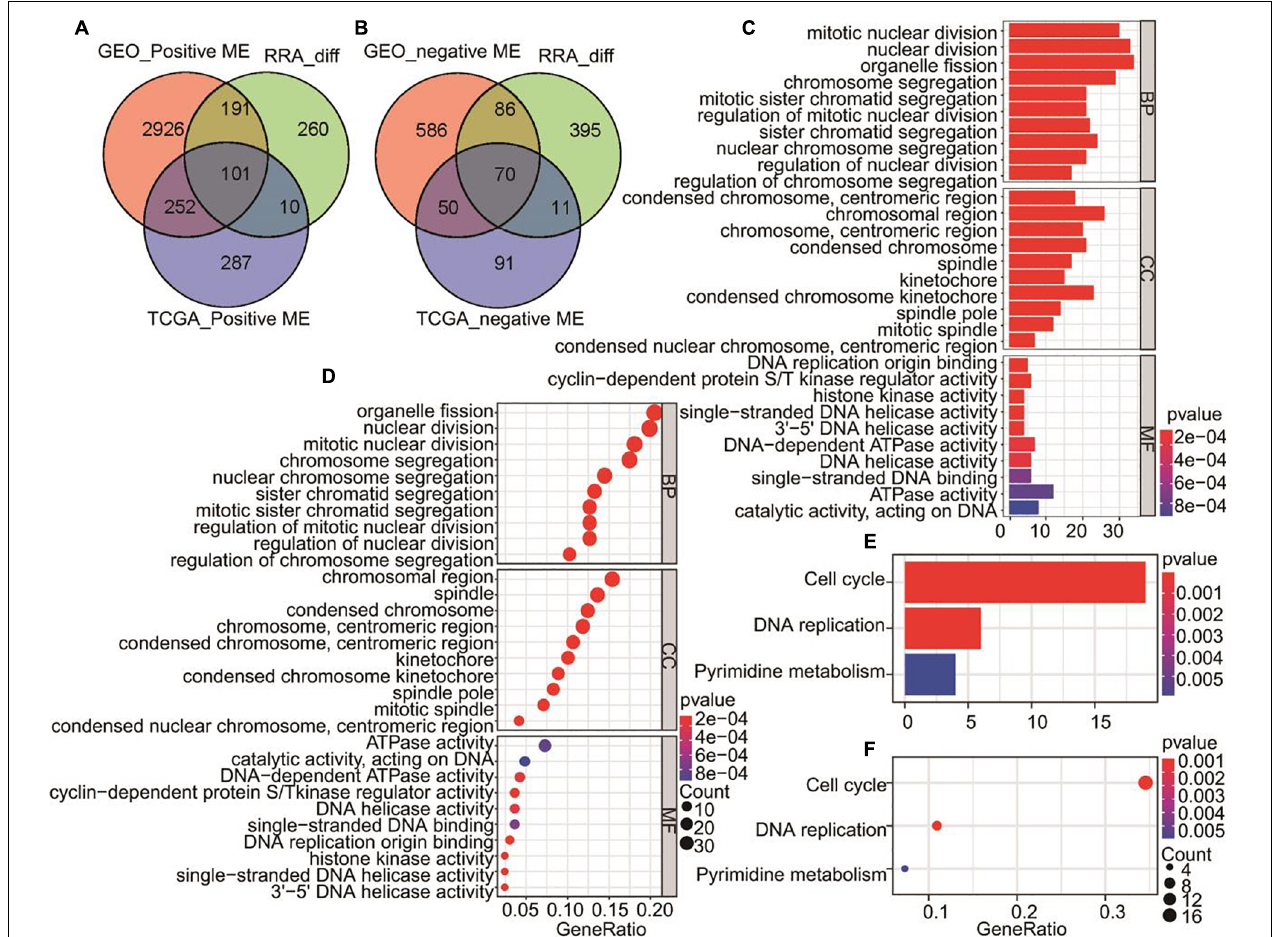
FIGURE 3 | Venn diagrams for overlapping DEGs and MEs significantly related to HCC and overlapped genes for GO and KEGG pathways analysis. (A) Tumor positive related genes. GEO_ positive MEs includes MEturquoise of GPL570, MEturquoise of GPL571, MEgrey of GSE64041, and MEgrey of GSE89377. (B) Tumor negative related genes. GEO_negative MEs includes MEblack of GPL570, MEbrown of GPL571, MEtan of GSE64041, and MEblack of GSE89377. (C) The bar plot of all overlapping genes by GO biological process. (D) The bubble plot showing all overlapping genes by GO biological process (E) KEGG pathways of all overlapped genes are shown in the bar plot. (F) KEGG pathways of all overlapped genes showed in the bubble